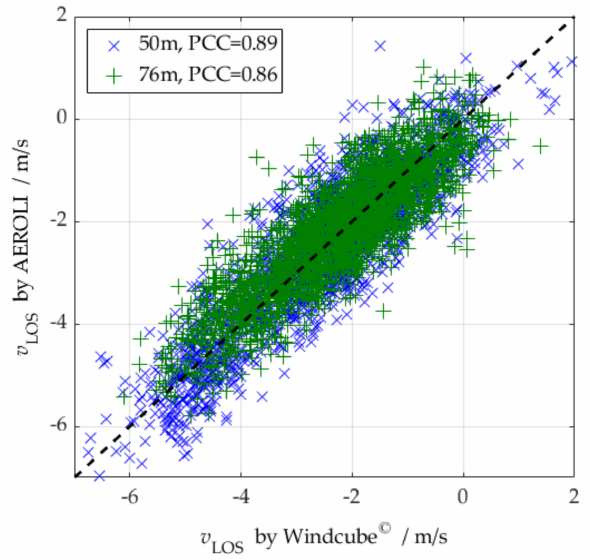
Figure 9. Correlation of the lidar measurement sets. The regression line is symmetric due to the prior subtraction of the